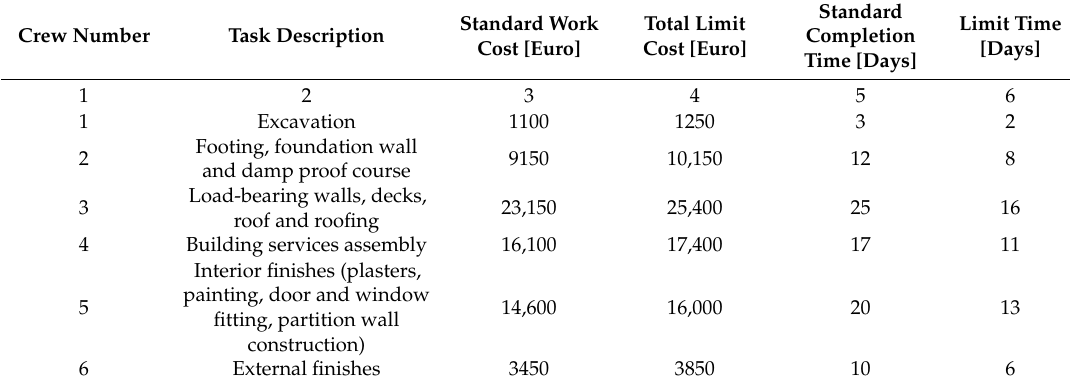
Table 4. Standard and limit costs of construction work and standard and limit construction work completion times, listed for individual works for a detached building with a floor area of 110 m 2